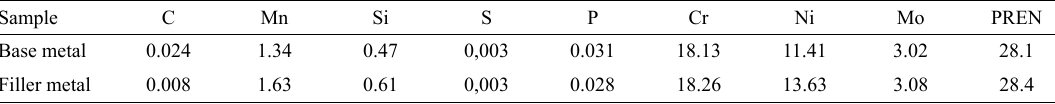
Table 2: Chemical compositions of weld metal and filler metal (Fe=bal.) Sample